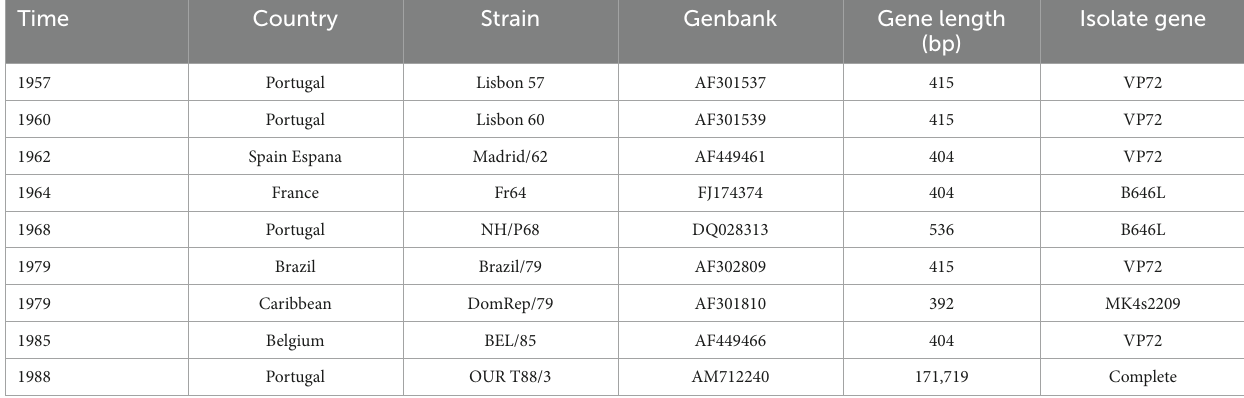
TABLE 2 The specific strain information of ASFV (Source: National Center for Biotechnology Information. https://www.ncbi.nlm.nih.gov/). Time